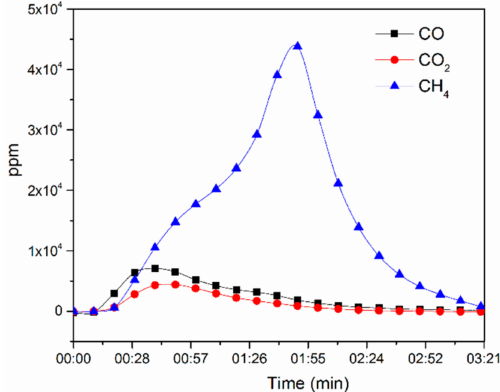
Figure 10. Gas analysis of metallized paper at 1500 ◦